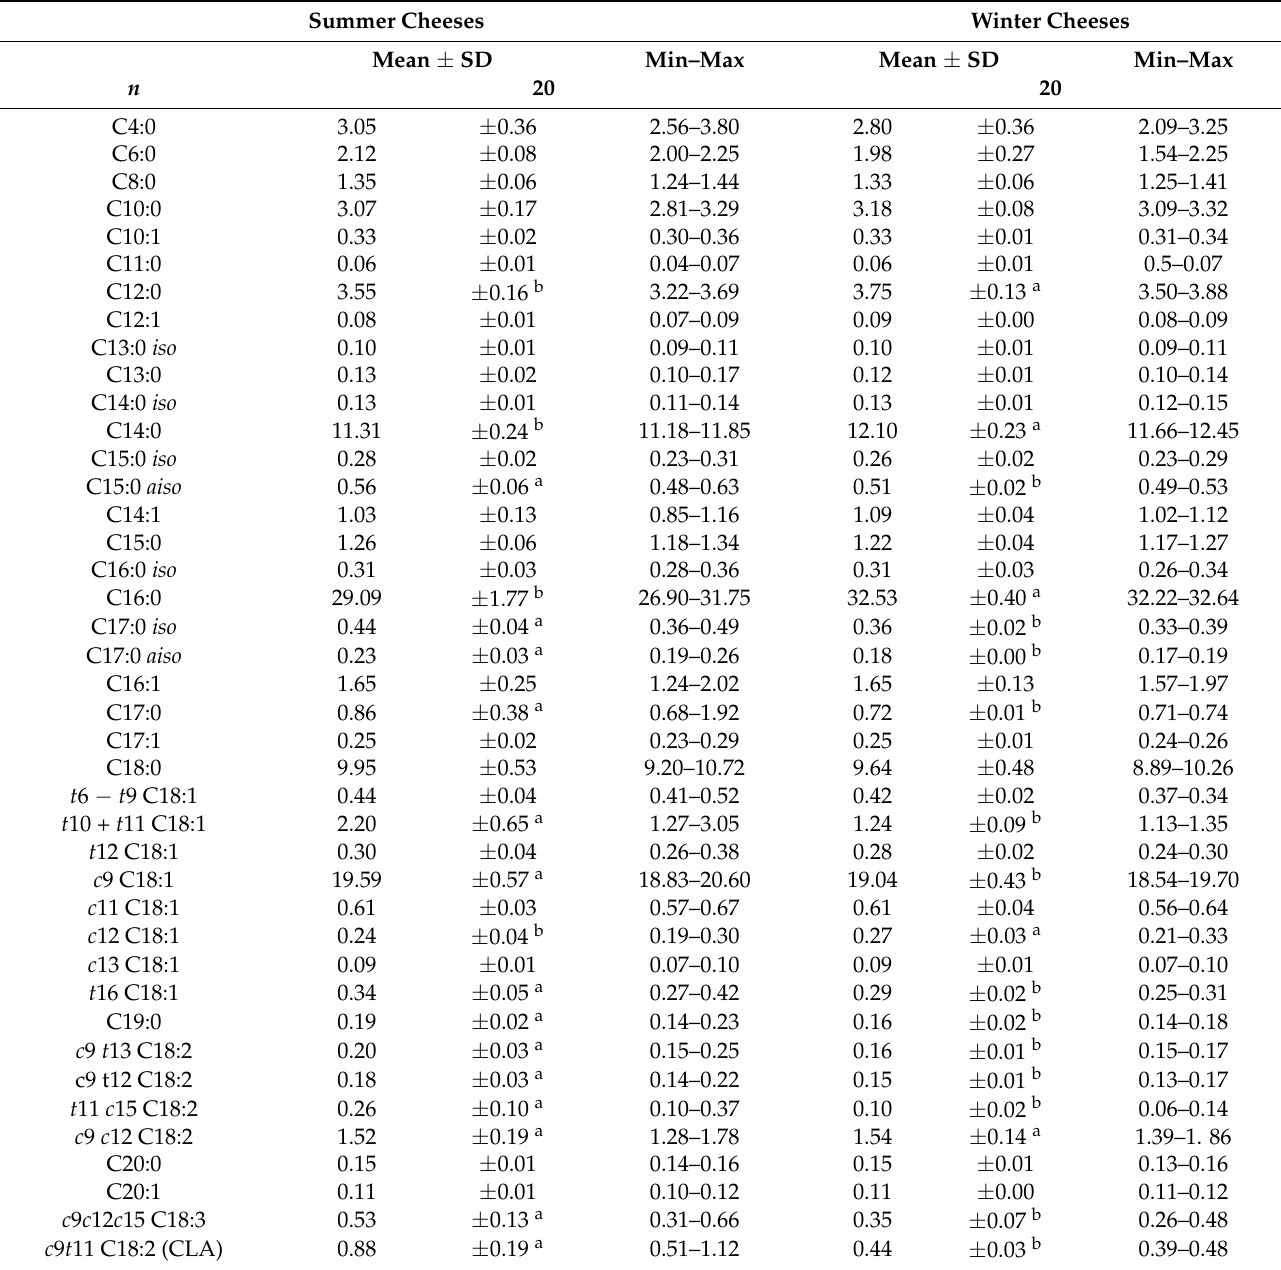
Table 3. Mean ± SD and range of fatty acids composition (% of total fatty acids) in summer and winter cheeses made from cow’s